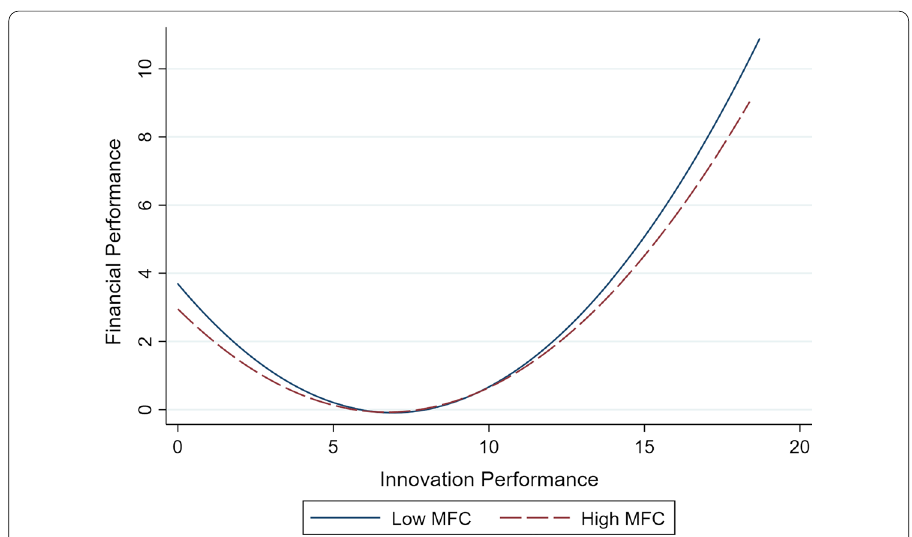
Fig. 3 Relationship between innovation output and financial performance under different levels of market-based financial